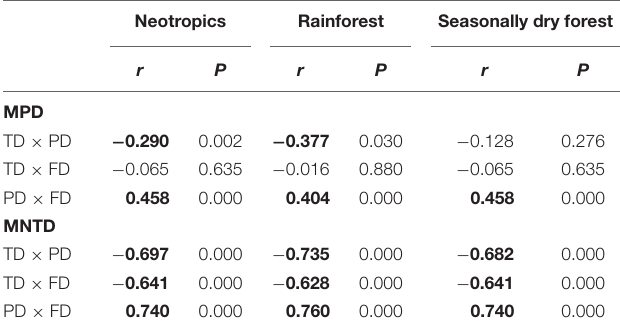
TABLE 2 | Correlation values from geographic weighted correlations among taxonomic, phylogenetic and functional diversity between rainforests and seasonally dry forest using MPD and